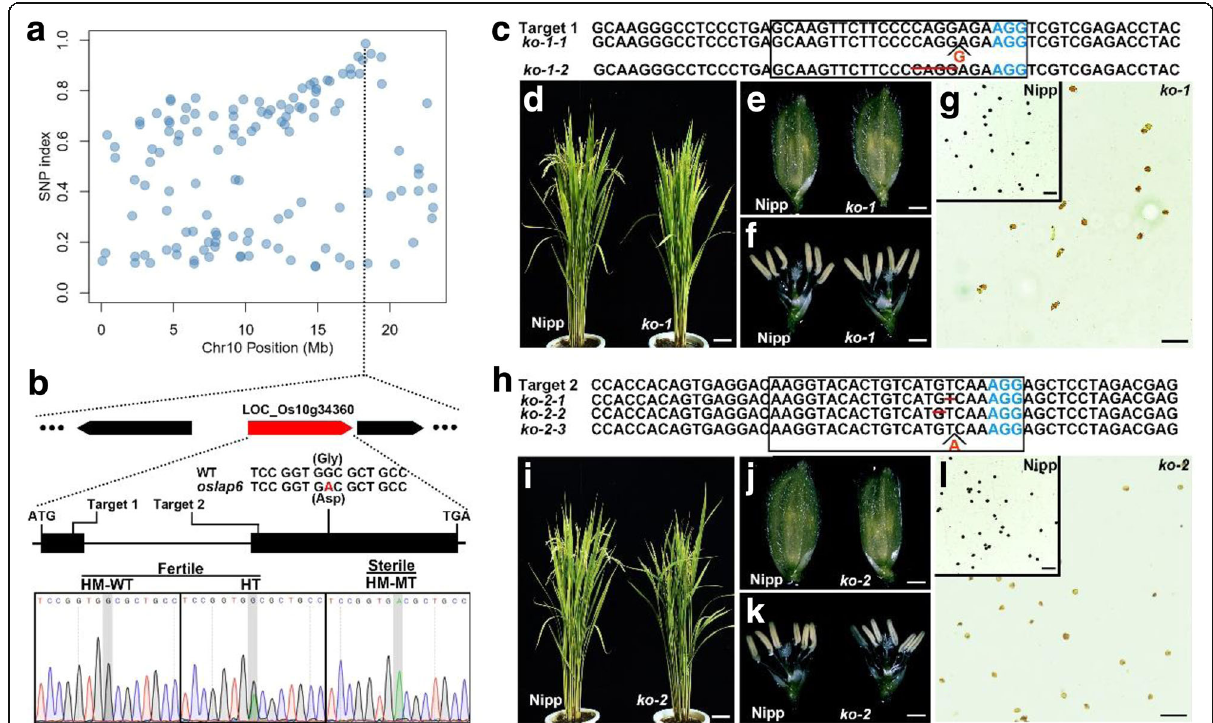
Fig. 4 Molecular detection of OsLAP6 and phenotypes of loss-of-function mutants. a The distribution of the SNP sites on chromosome 10. b OsLAP6 gene structure, the mutation site of oslap6 mutant, two independent sgRNA targeting sites of CRISPR/Cas9 system, and the identification of the OsLAP6 gene in the oslap6/9311 F2 population by sequencing. The black boxes indicate the exons. The red characters indicate the SNP mutation in OsLAP6 gene. c and h Sequence alignment of the homologous mutants within the target1 and target2 in the ko-1 and ko-2 T 0 plants, respectively. The black frames indicate the target sequences; and the PAM sequences and mutations are in blue and red, respectively. d-g Phenotype of WT and ko-1 in the Nipponbare (Nipp) background. i - l Phenotype of WT and ko-2 in the Nipp background. d and i Plants after heading. e and j Spikelets. f and k Spikelets with the palea and lemma removed. g and l Pollen grains with I 2 -KI staining. Scale bars=5 cm ( d and i) ; 1.5 mm ( e and j ); 1 mm ( f and k ); 150 μ m ( g and l )